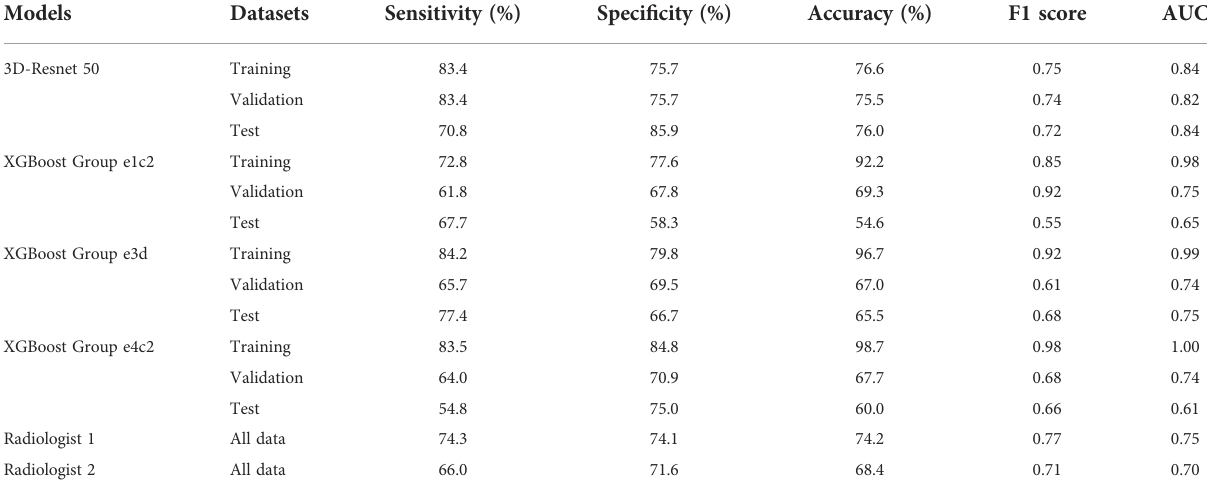
TABLE 3 Comparison of the predictive performance in 3D-Resnet 50, radiomics, and radiologists in the training, validation and test cohort.